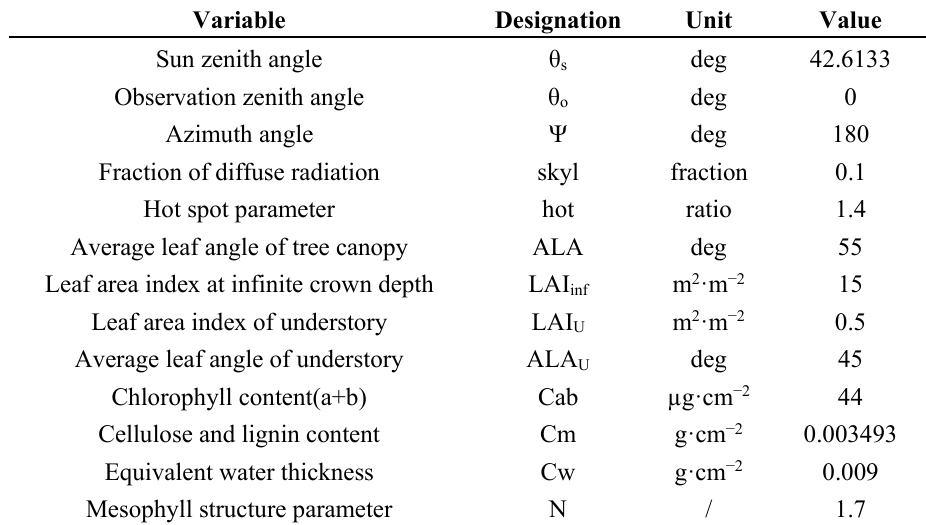
Table 4. INFORM parameters kept constant during model simulations.